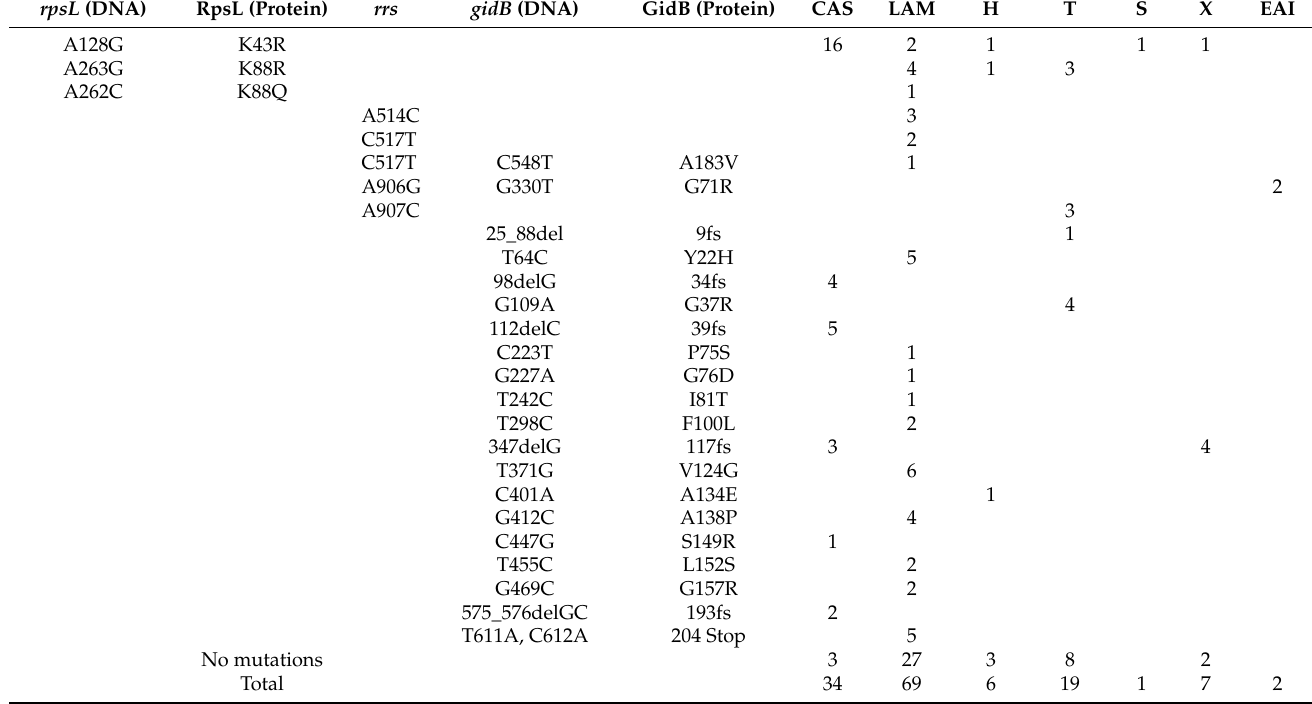
Table 3. Distribution of rpsL , rrs, and gidB mutations among different genotypes. rpsL (DNA) RpsL